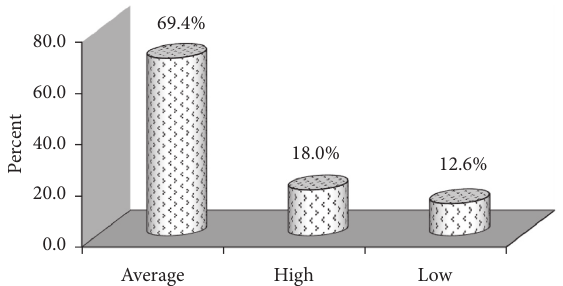
Figure 5: Contribution of agriculture skills developed on food